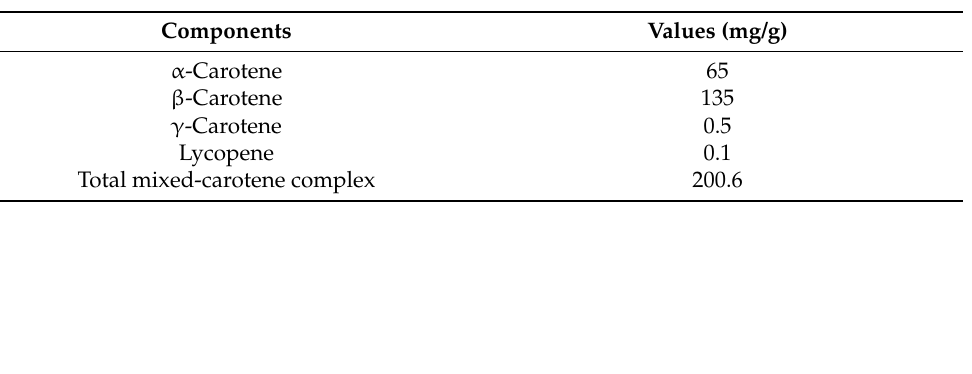
Table 1. Composition of total mixed-carotene complex 20% oil concentrate